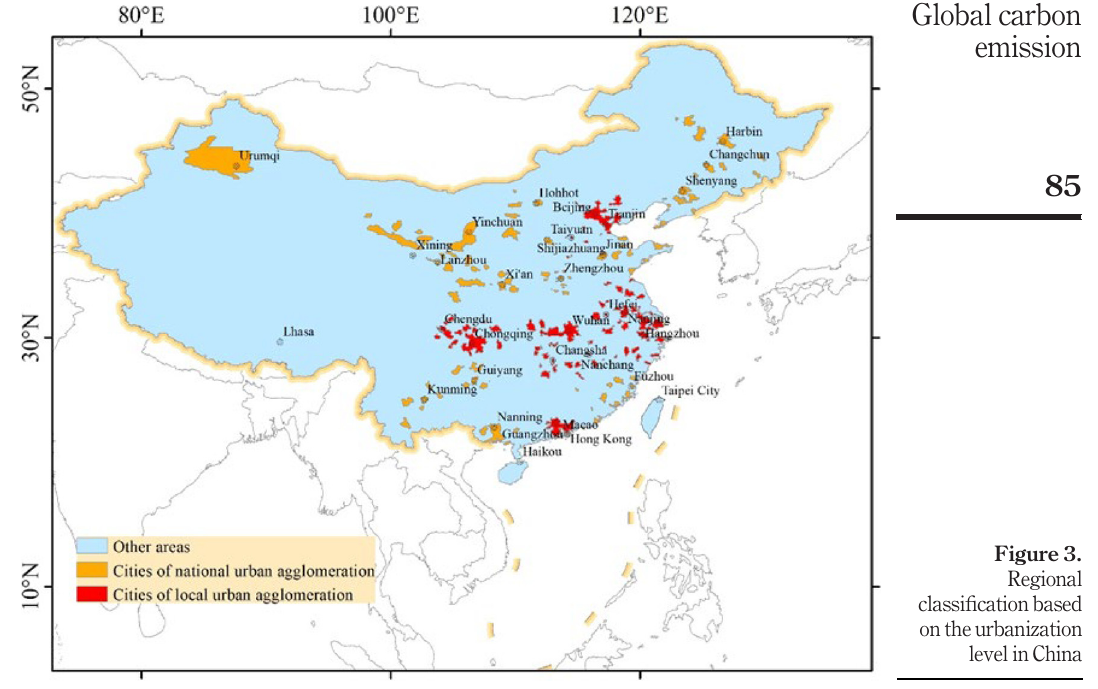
Figure 3. Regional classi fi cation based on the urbanization level in